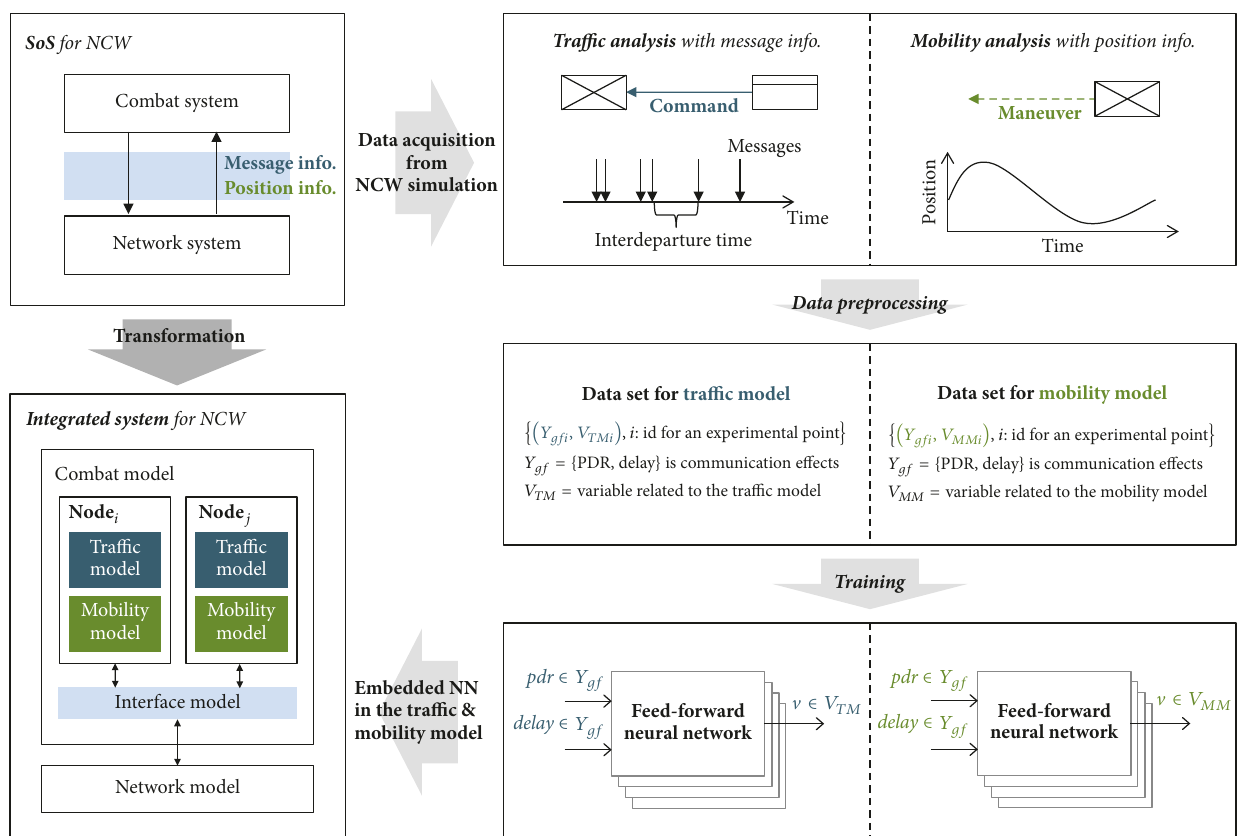
Figure 5: Proposed transformation procedure of the SoS into the integrated system.